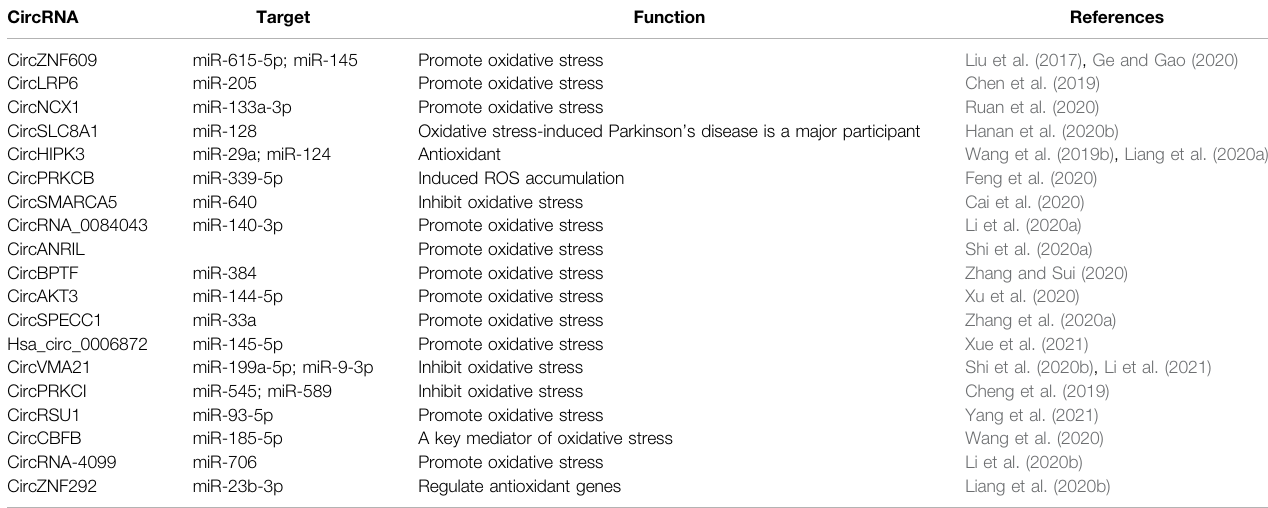
TABLE 1 | CircRNA regulates oxidative